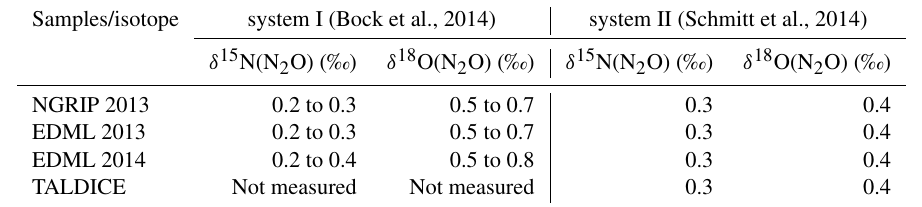
Table 1. Measurement precision ( ± 1 standard deviation) of N 2 O isotope ice core data measured at the University of Bern in this study.